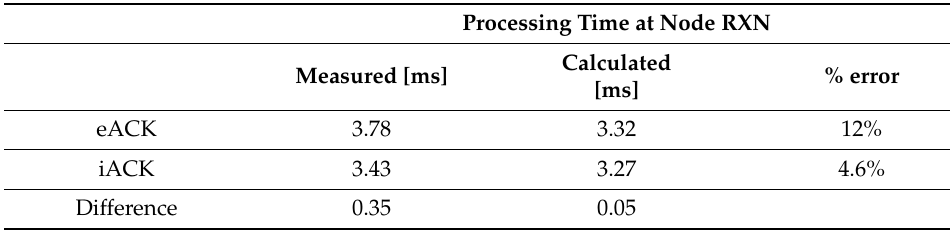
Table 6. Frame processing time (RXN node).